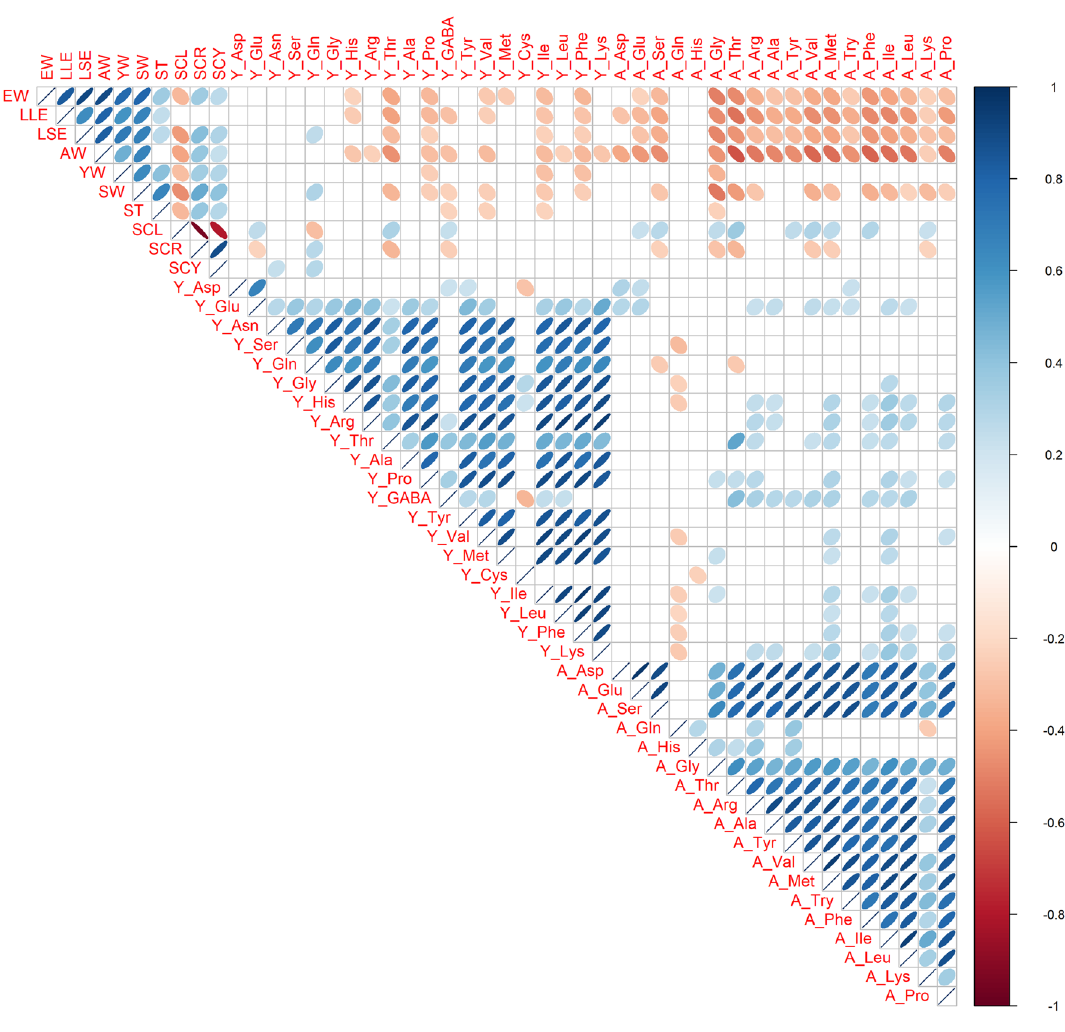
Figure 1. Phenotypic correlations among all 48 egg traits and free amino acid traits. Ten egg traits, 20 yolk amino acids traits, and 18 albumen amino acids traits from a total of 81 hens (AUS, NGY, RIR, SHA, UKO, NGYxRIR, and SHAxRIR) were used. Trait abbreviations are shown in Methods. Pearson’s correlations are expressed by ellipses. Blue and red ellipses indicate positive and negative correlations in each pair ( p < 0.05). Blank cells show not